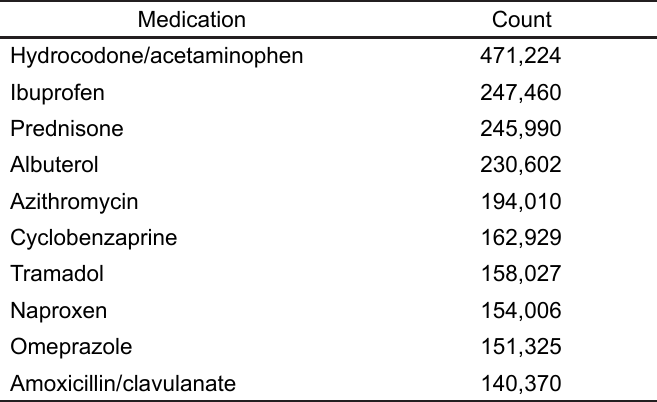
Table 2. Most frequently prescribed medications in the ED cohort.